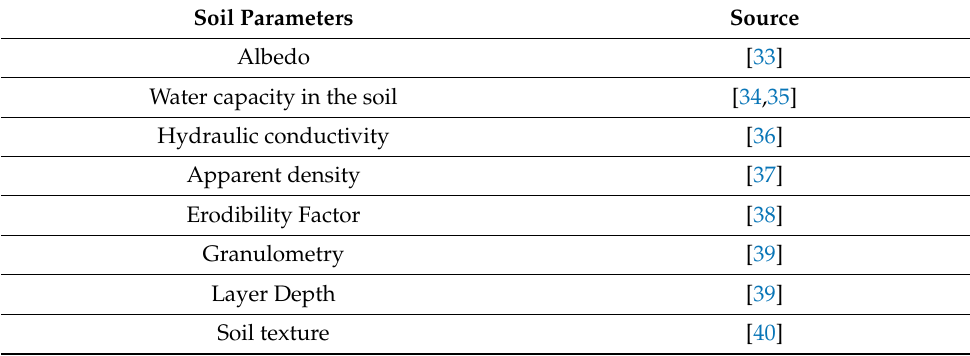
Table 2. Characteristics of soil classes in the Rio Grande Basin, RJ. Soil Class Features Deep soils with good drainage, not hydromorphic, and red and Argissolos (Podzolic) yellow textural B horizon. Poorly developed, shallow, non-hydromorphic soils with Cambisols considerable silt content. Well developed soils with a high degree of weathering, presenting Latosols great depth, good drainage and latossolic b horizon. Soils with a low degree of development, presenting little depth Litholic Soils with the A horizon over rock or in B or C horizons of little thickness. In its composition, gravel and rock pebbles predominate.